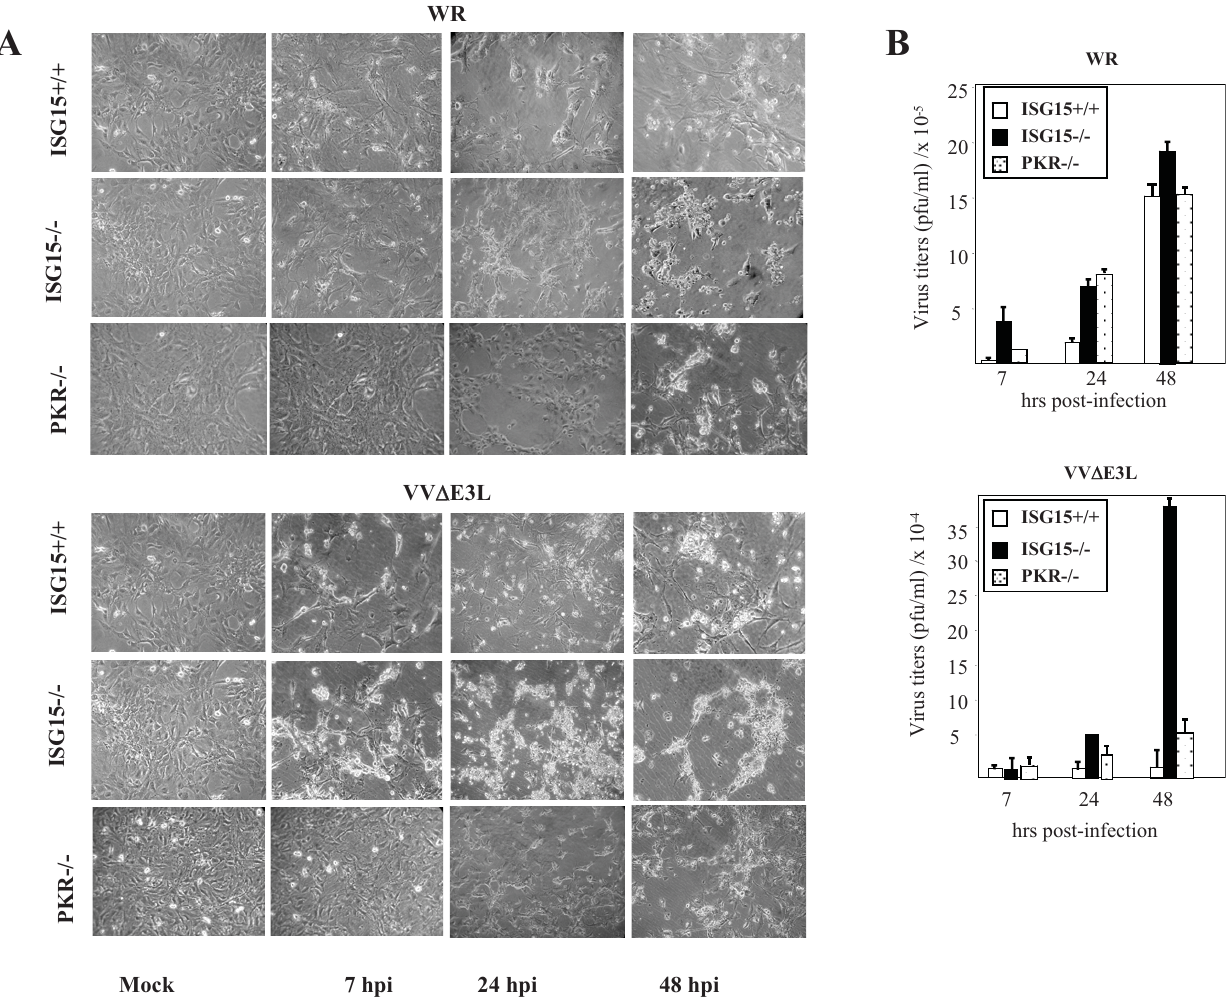
Figure 2. Effect of ISG15 on cytotoxicity and virus growth after infection of MEFs with virulent and E3L deletion VACV mutant viruses. A . ISG15 2 / 2 , PKR 2 / 2 or wild type cells were mock-infected or infected at 0.1 PFU/cell with WR or VV D E3L. At different times p.i, the CPE in the cells was examined by phase-contrast microscopy. B . Virus growth of WR and VV D E3L infected (0.1 PFU/cell) ISG15 + / + , or ISG15 2 / 2 , or PKR 2 / 2 cells. At different times cells were harvested and virus yields were determined by plaque assay for WR or by immunostaining for VV D